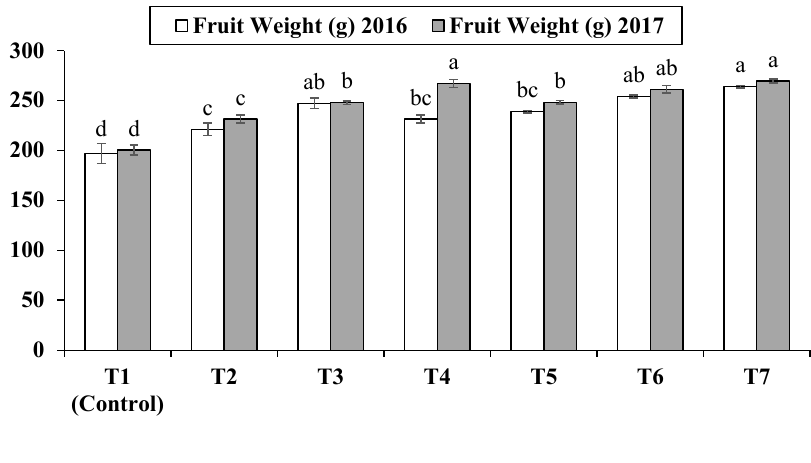
Figure 2. Effects of foliar application of variable sources of Ca and K with B on SB Chaunsa fruit weight